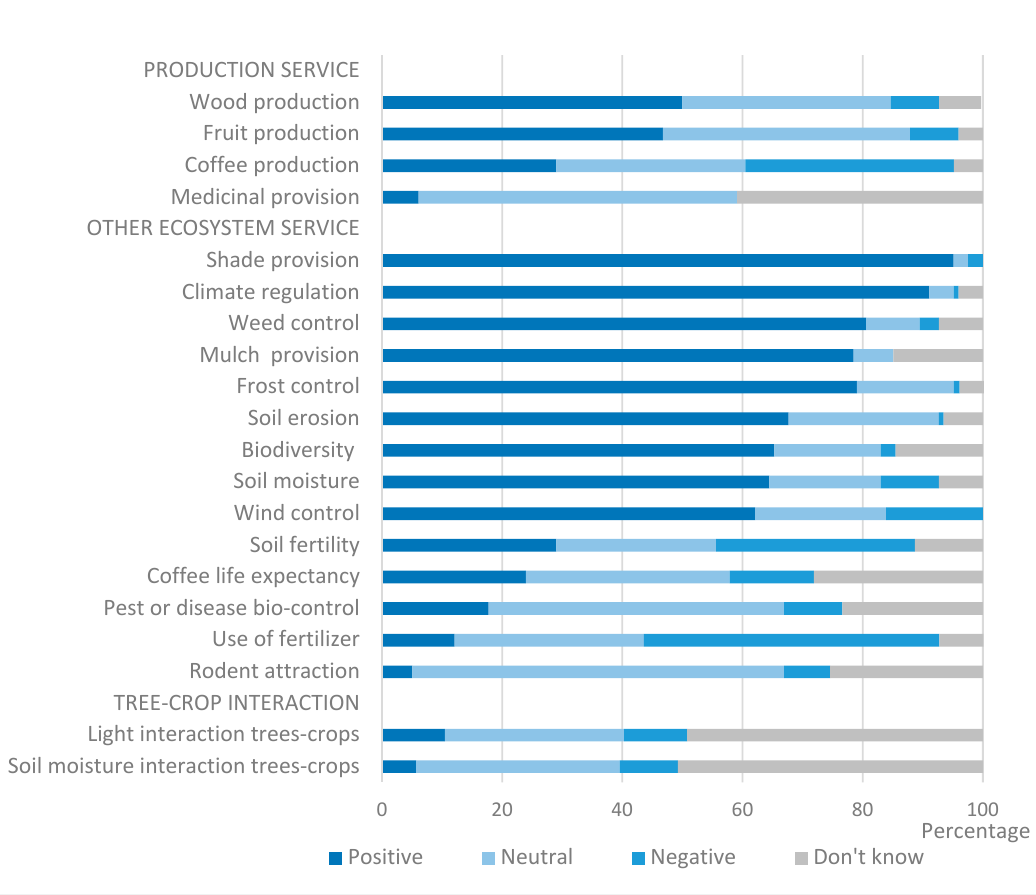
Figure 5. Farmers’ perspectives on tree services to coffee in agroforestry practices in the two provinces of Son La and Dien Bien, northwest Vietnam.